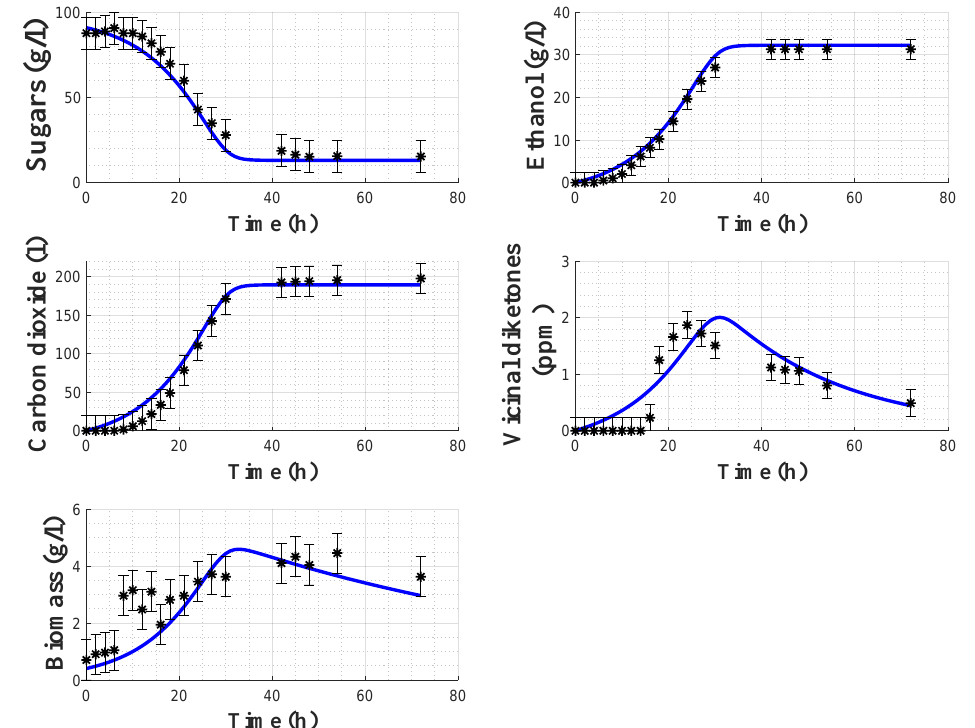
Figure 4. Cross-validation of the biomass model with the data from experiment 1. Stars: experimental data. Error bars: 95% confidence intervals. Continuous blue line: model